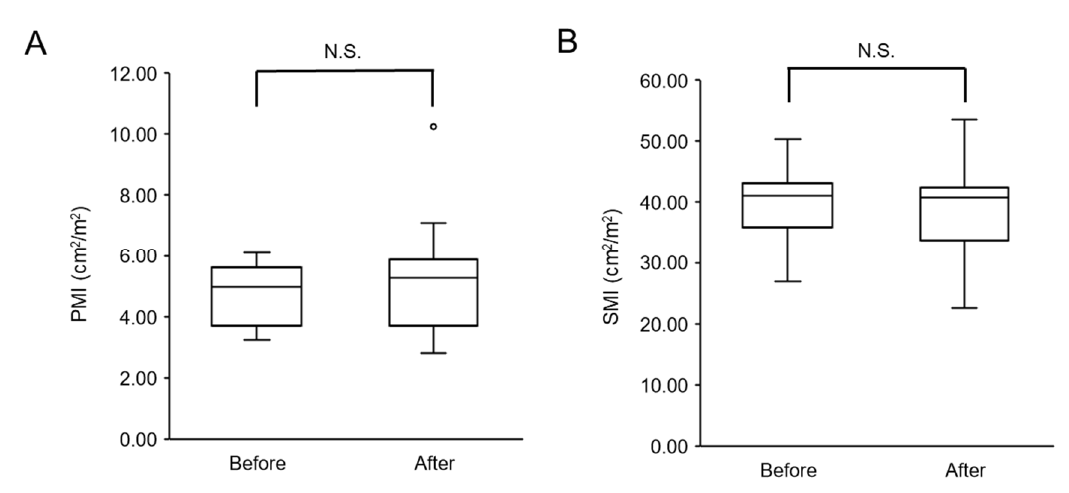
Figure 2. Changes in walking speed and muscle strength after physical therapy. ( A ) Walking speed, ( B ) grip strength, ( C ) right knee extension strength, ( D ) left knee extension strength, and ( E ) CS-30. Abbreviations: N.S.—not significant; CS-30—30-s chair–stand test. 3.2.3. Changes in FIM Score and All Items of FIM after Physical Therapy The total FIM score was significantly increased after physical therapy compared with before physical therapy (Figure 3). The stairs index is a motor index of FIM, and was the only item that was